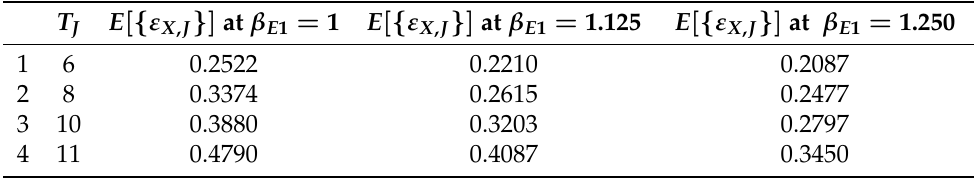
Table 2. Tabulation of E [ { ε X , J } ] from Figure